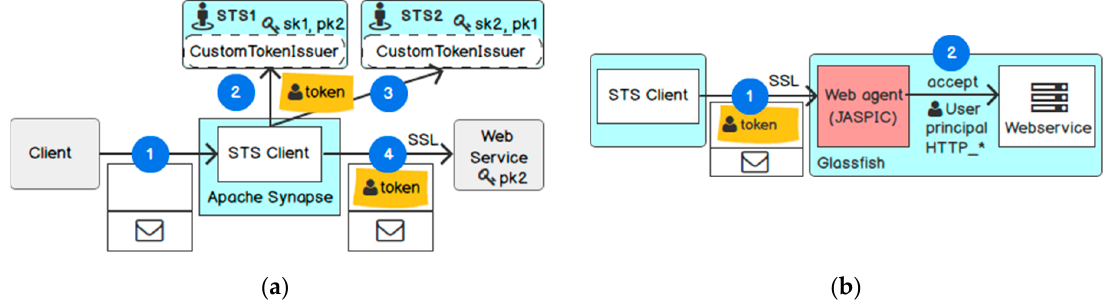
Figure 11. ( a ) Proxy implementation; ( b ) Intercepting Web agent implementation.